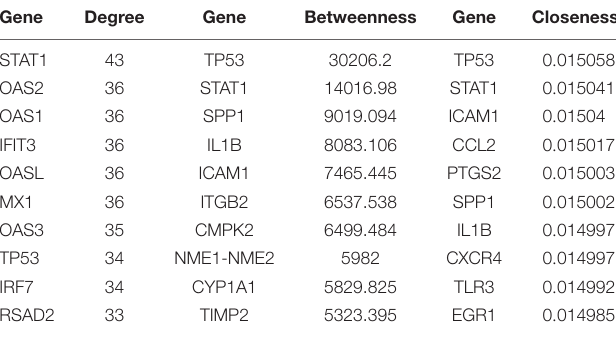
TABLE 1 | The top 10 hub genes in PPI network were identified as candidate genes related to ovarian cancer according to topological properties (degree centrality, betweenness centrality, and closeness